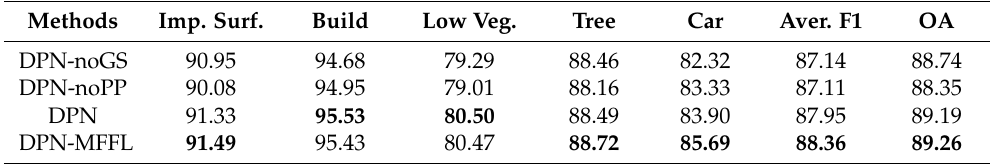
Table 1. Experimental results on the Vaihingen validation dataset. DPN-noGS: DPN without group convolutions and shuffling operation version; DPN-noPP: DPN without the pyramid pooling module version; DPN: the proposed DPN trained by standard cross entropy loss function; DPN-MFFL: DPN trained by median frequency balanced focal loss.